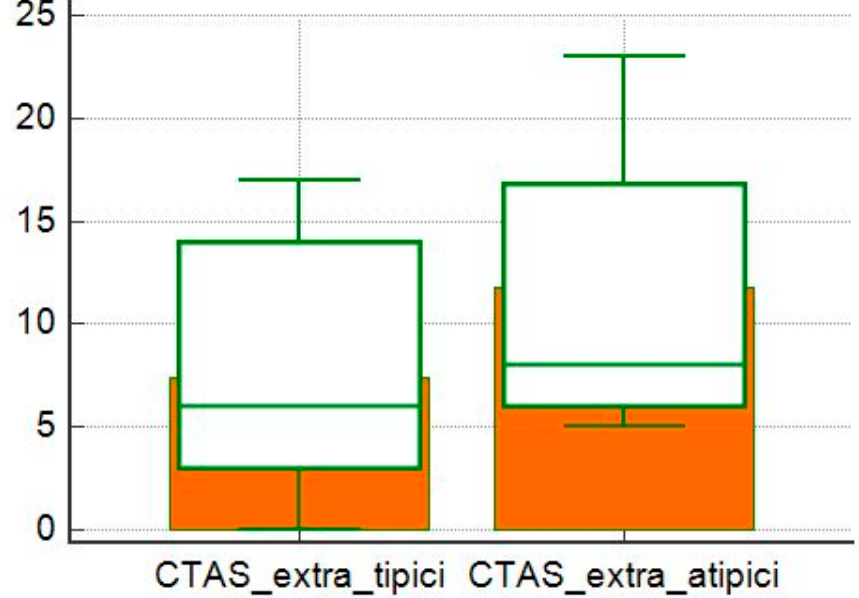
Figure 10. Comparison of CTAS averages between typical and atypical subgroups of patients with extra-thoracic localization.